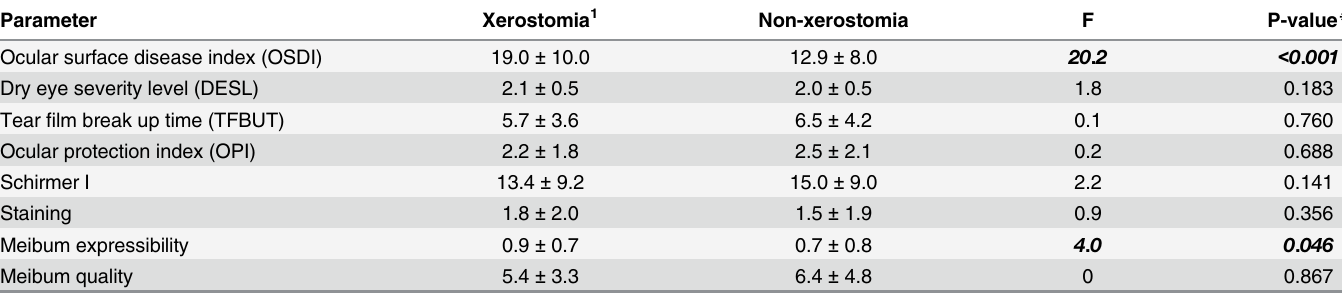
Table 4. Severity of Ocular Signs in Patients with/without